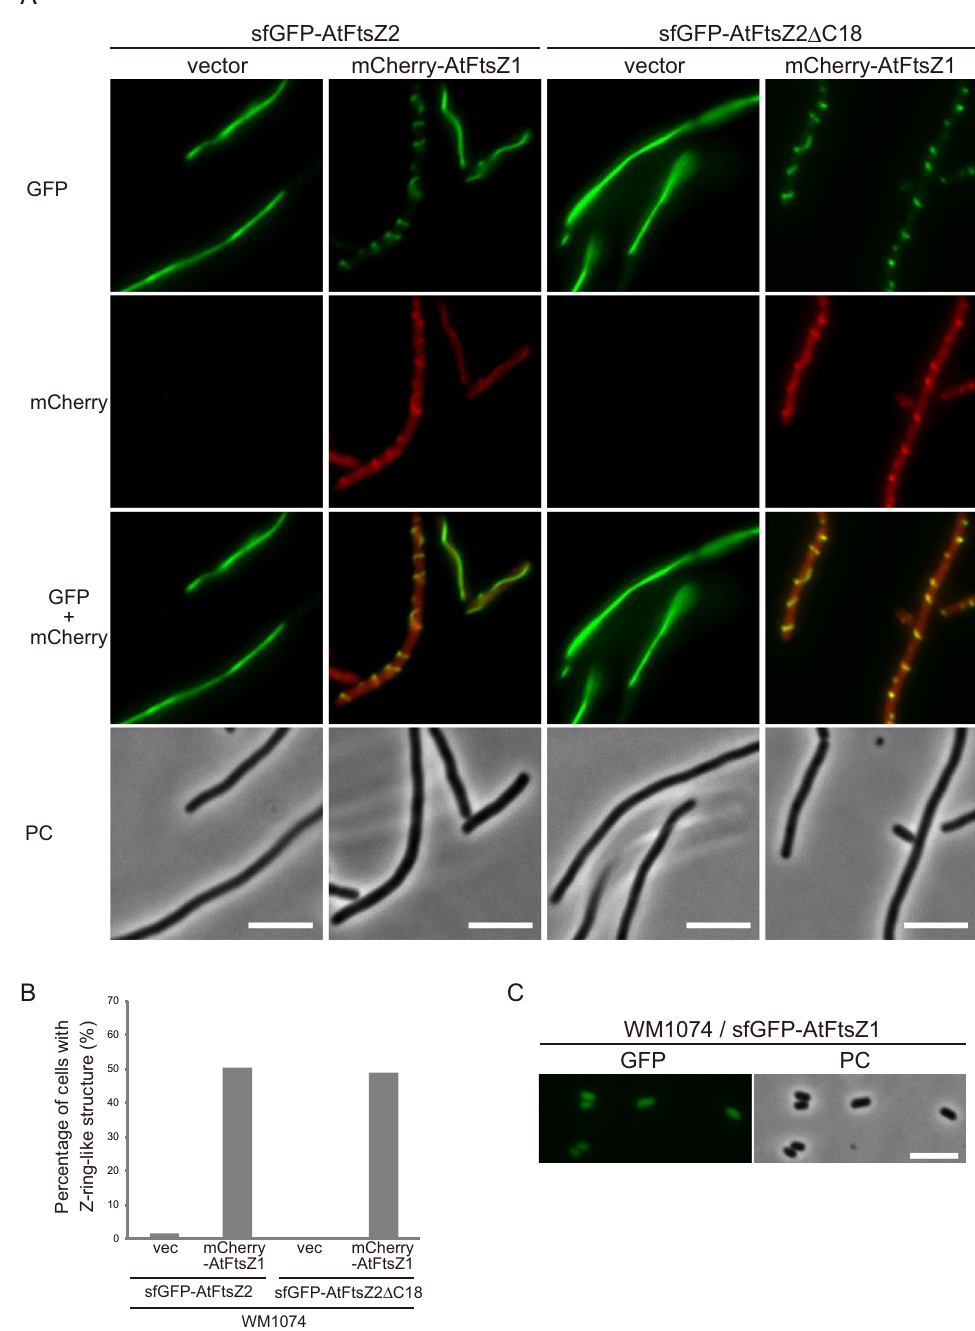
Figure 5. FtsZ1 affects the filament morphology of FtsZ2 in E. coli cells. ( A ) Effect of AtFtsZ1 expression on the filaments of AtFtsZ2 with or without the partially conserved C-terminal sequence in the WM1074 strain. Scale bar: 5 µ m. ( B ) Quantification of the Z ring-like signal of sfGFP-AtFtsZ2 expressed with or without mCherry- AtFtsZ1. The graph shows the percentage of cells containing > 1 Z-ring-like structure. The numbers of elongated bacterial cells investigated for the quantification were 60 (WM1074/sfGFP-AtFtsZ2 & vector, + NaSal), 107 (WM1074/sfGFP-AtFtsZ2 & mCherry-AtFtsZ1, + NaSal), 49 (WM1074/sfGFP-AtFtsZ2 ∆ C18 & vector, + NaSal) and 90 (WM1074/sfGFP-AtFtsZ2 ∆ C18 & mCherry-AtFtsZ1, + NaSal). ( C ) Fluorescence image of sfGFP-AtFtsZ1 expressed by itself in the WM1074 strain. Scale bar: 5 µ